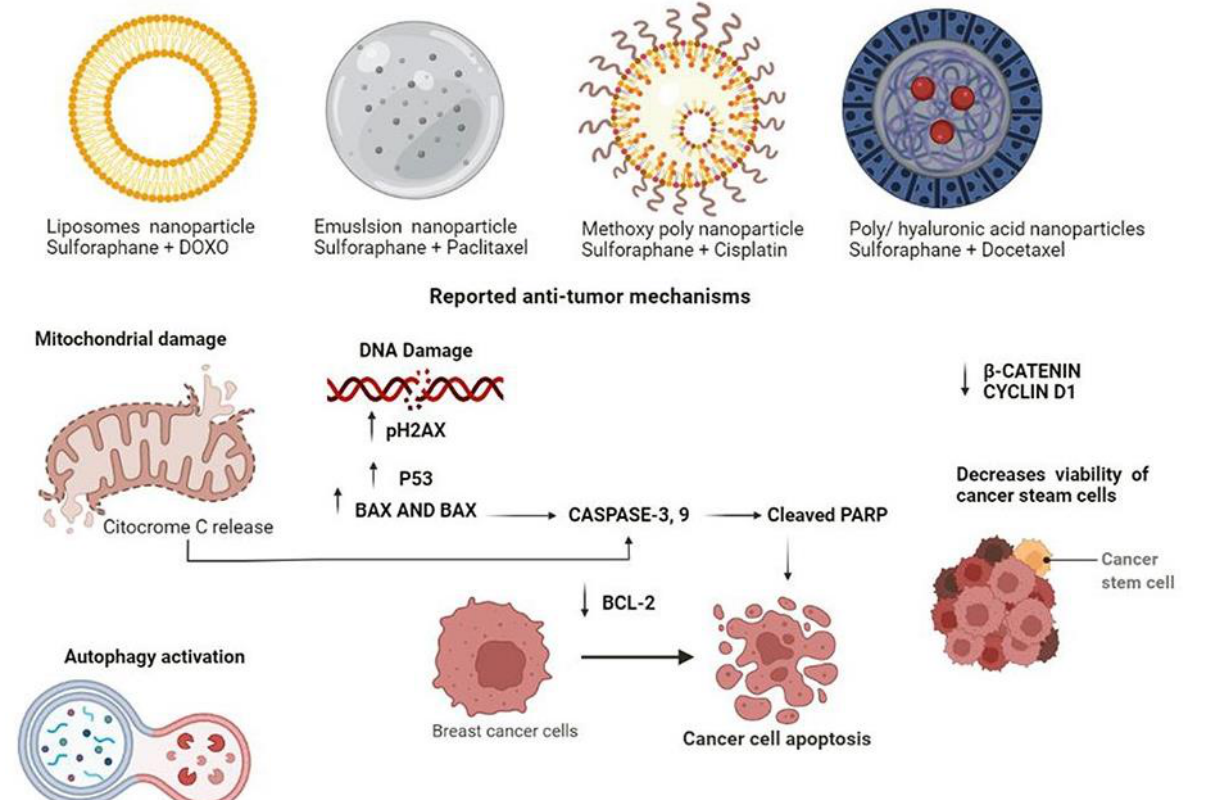
Figure 2. Reported anti-tumour mechanisms of sulforaphane as adjuvant. Mechanisms reported for liposome nanoparticles microemulsion, methoxy poly (ethylene glycol)-poly (lactide-co-glycolide) and poly (D, L-lactideco-glycolide)/hyaluronic acid nanoparticles loaded with sulforaphane and chemotherapeutic agents such as DOX, PTX, cisplatin, and DTX. Among the biological mechanisms